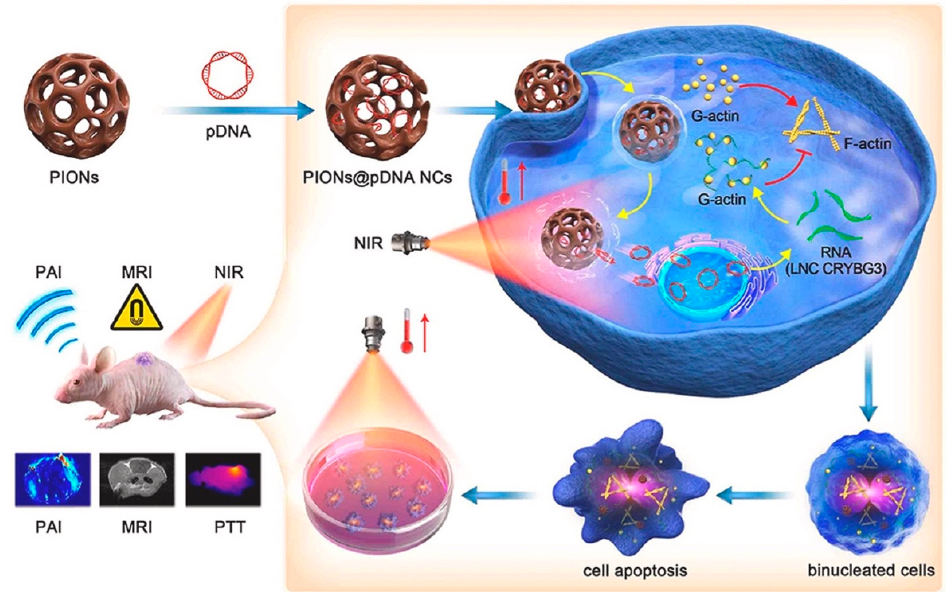
Figure 5. Porous iron oxide nanoparticles (PIONs) loaded with pcDNA3.1 − LNC CRYBG3 nanocom- plexes (PIONs@pDNA NCs) showed the synergistic ability of MRI, photothermal therapy, and gene therapy to achieve tumor − targeted therapeutics and diagnosis. Reprinted with permission from Ref. [103]. Copyright 2021,